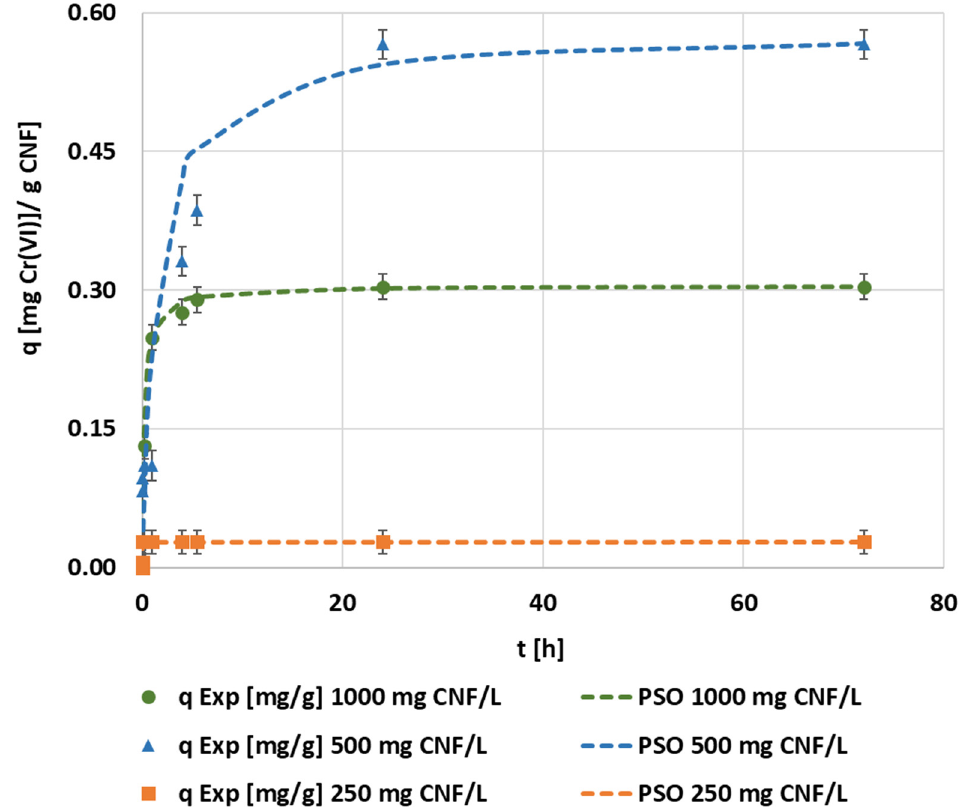
Figure 9. The evolution of the kinetic adsorption experiment at 0.1 mg · L − 1 of the chromium initial concentration, 1.5 mmol MTMS · g − 1 CNF, and pH 3 conditions under different adsorbent dosages and kinetic fitting of the pseudo-second order model.